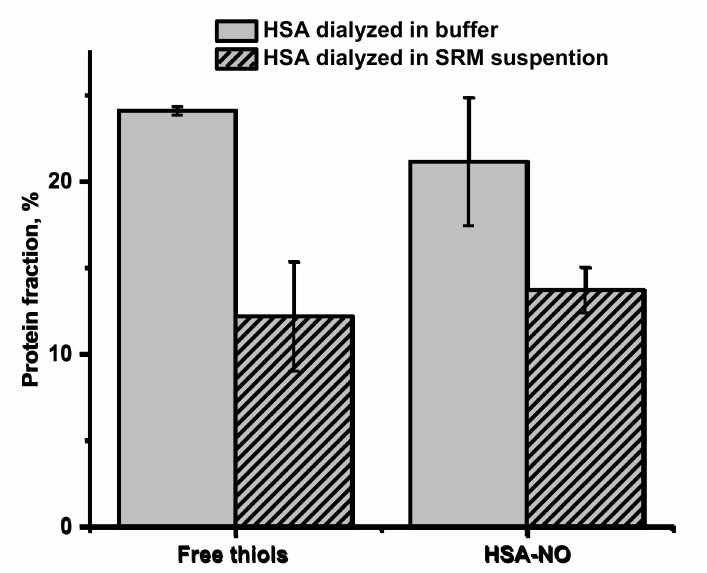
Figure 4. Free thiols groups in HSA and S-NO moieties in HSA (HSA-NO) resulting from S-trans- nitrosation of HSA using GSNO presented as percentage of protein fraction (plain gray: HSA dialyzed in Tris buffer pH 7.8, stripped gray: HSA dialyzed in buffered suspension of SRM). Bars represent the means ± SD of three independent